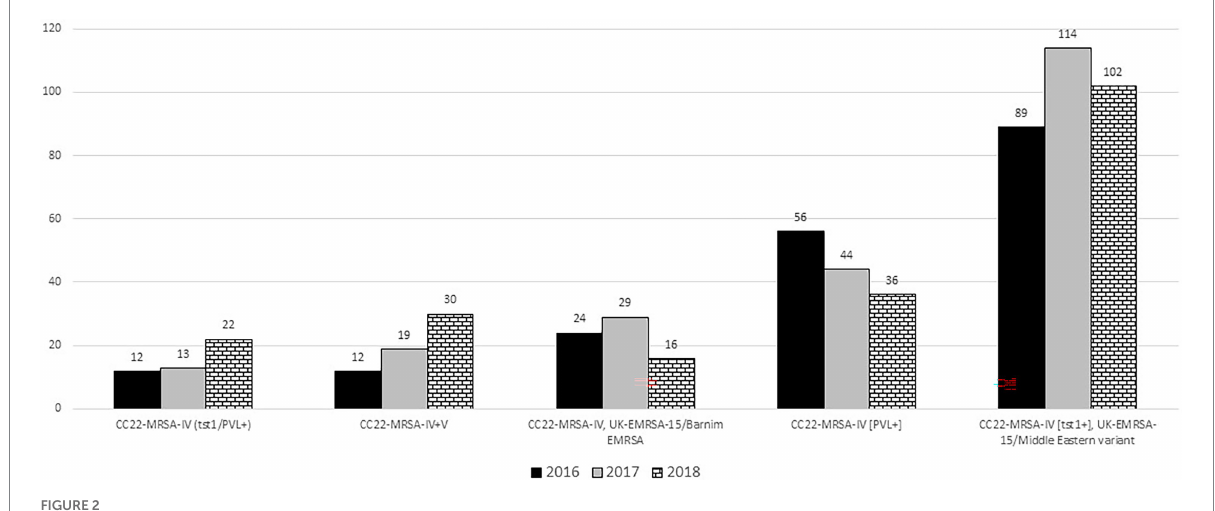
FIGURE 2 Distribution of the common CC22-MRSA genotypes in